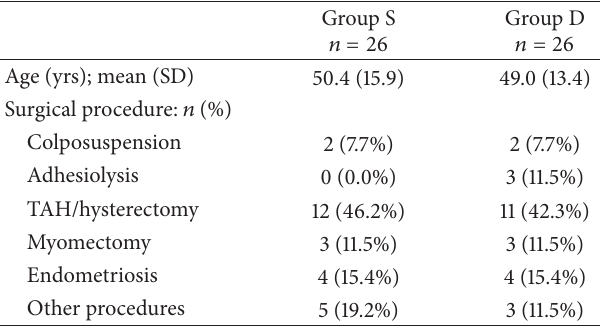
Table 2: The patient population and descriptions of surgeries performed. There was no statistically significant difference between